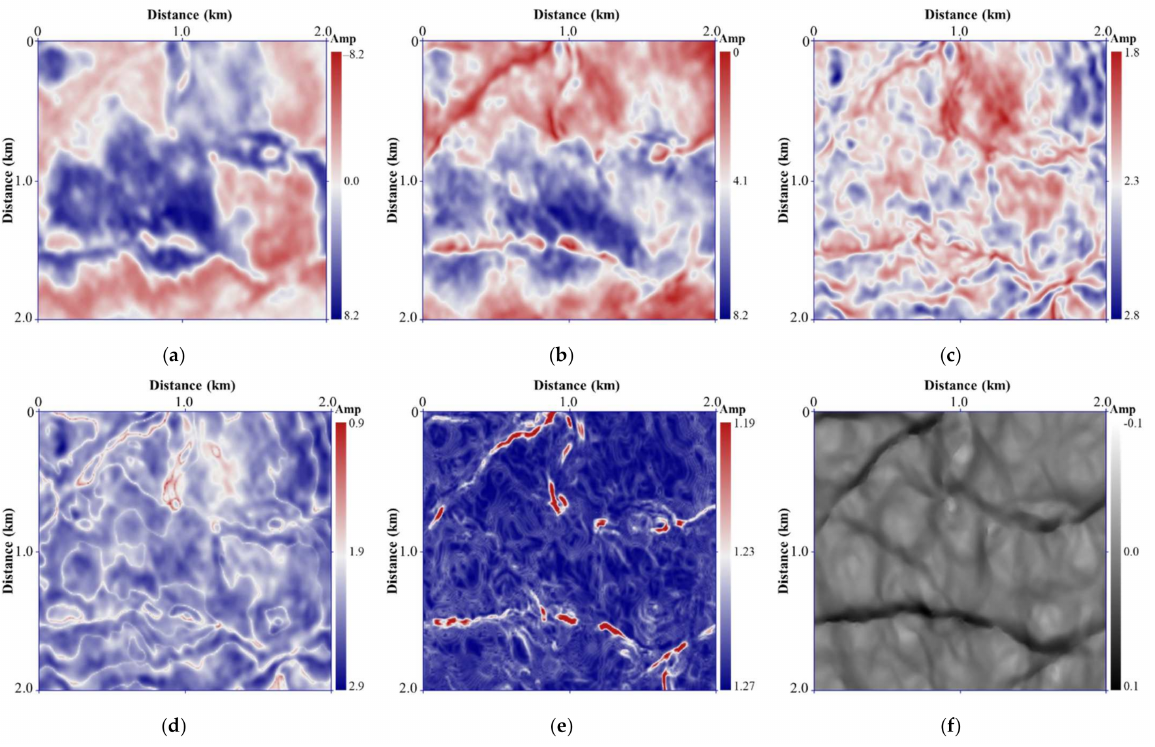
Figure 6. Time slices at 1.7s: ( a ) amplitudes; ( b ) instantaneous amplitudes; ( c ) instantaneous am- plitudes obtained by GHT with p = 6; ( d ) instantaneous amplitudes obtained by LTFS with p = 6, f 1 = 0 Hz, and f 2 = 90 Hz; ( e ) most positive curvatures; ( f ) third-generation coherences